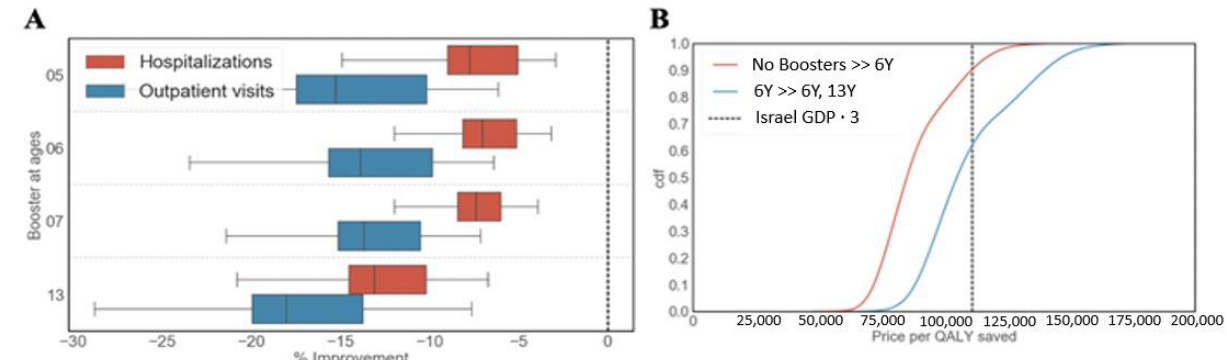
Figure 4. Cost-effectiveness of existing booster doses. ( A ) Effectiveness of different vaccination schedules of a single booster dose as projected by our model in terms of reducing pertussis outpatient visits and hospitalizations. Effectiveness is reported as the percentage of improvement compared to the optimal two-booster vaccination schedule that targets children at the ages of 6 and 13. ( B ) Cost-effectiveness of the optimal single-booster schedule compared to the no-booster schedule and the optimal two-booster schedule. The dashed vertical line represents $110,000, which corresponds to three times the per capita GDP of Israel.